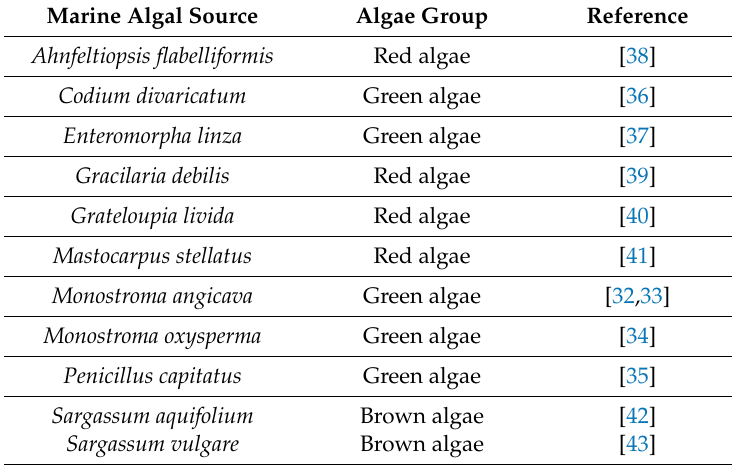
Table 4. Marine algae source with anticoagulant activity attributed to